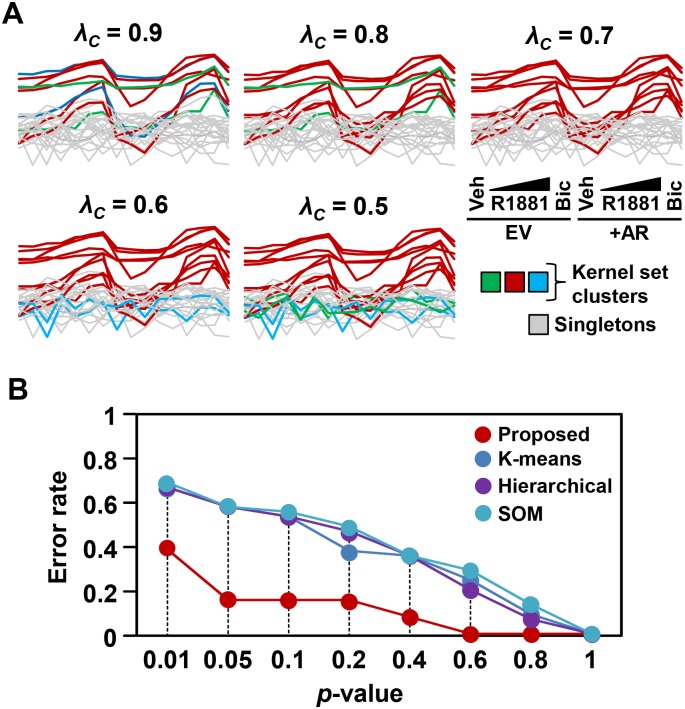
The kernel set clustering of androgen receptor (AR) target genes.A) Clusters identified within AR kernel set at different correlation thresholds. Different clusters are identified by different colours. Singletons are greyed out. B) Error rates of the recovery of AR known TGs (kernel set) at different p-value cut-offs using leave-one-out cross validation test. The proposed clustering algorithm was also replaced with commonly used clustering methods (i.e., K-means, hierarchical and self-organizing map) to illustrate the importance of the clustering component on the recovery of AR target genes.